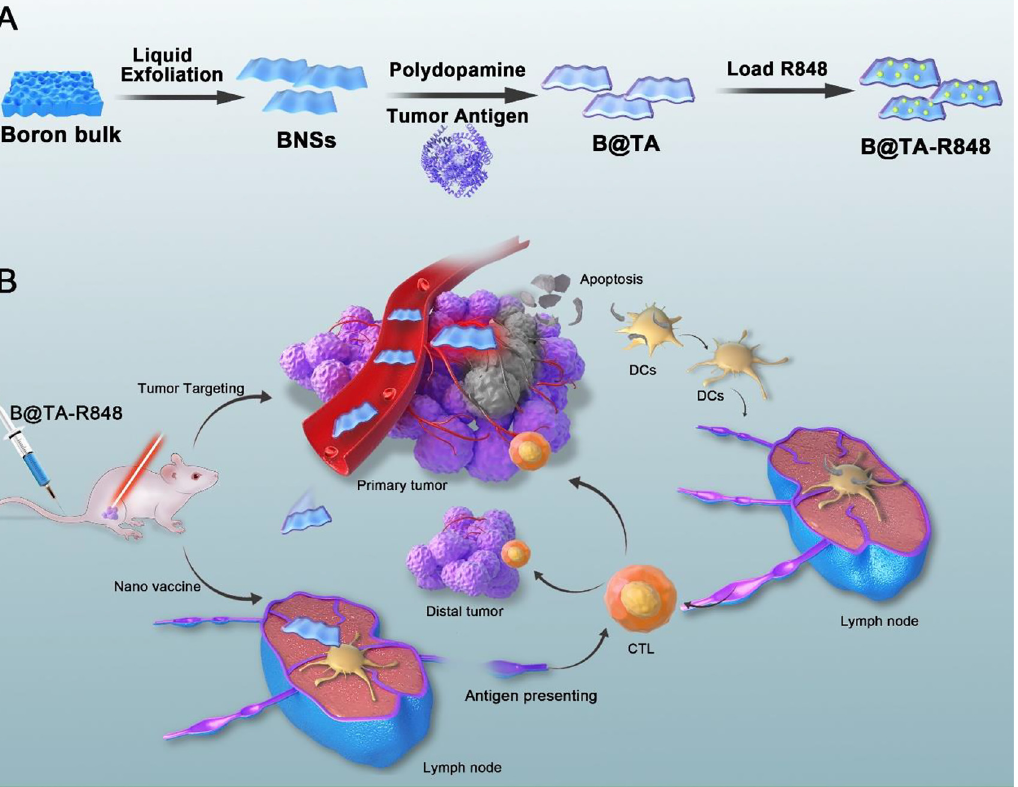
Figure 1: Schematic depiction of B@TA-R848 for enhanced personalized photothermal-immunotherapy. (A) The preparation of B@TA-R848. (B) The systemic delivery of B@TA-R848 as a photo nanovaccine for multimodal imaging-guided cancer therapy (BNSs: Two-dimensional boron nanosheets; TA: Tumor autoantigens; DCs: Dendritic cells; and CTL: Cytotoxic T